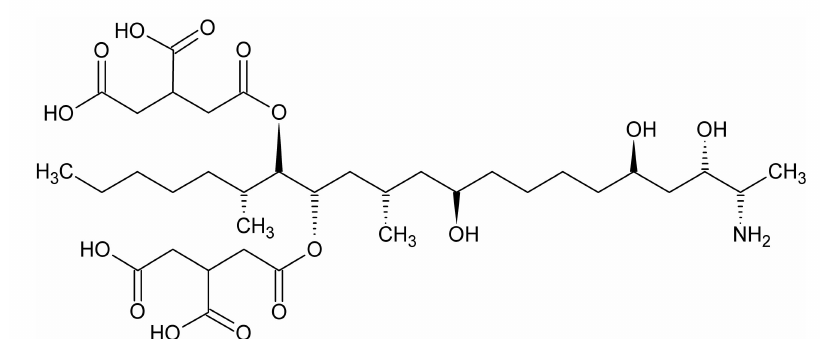
Figure 1. Structure of fumonisin B 1 molecule.